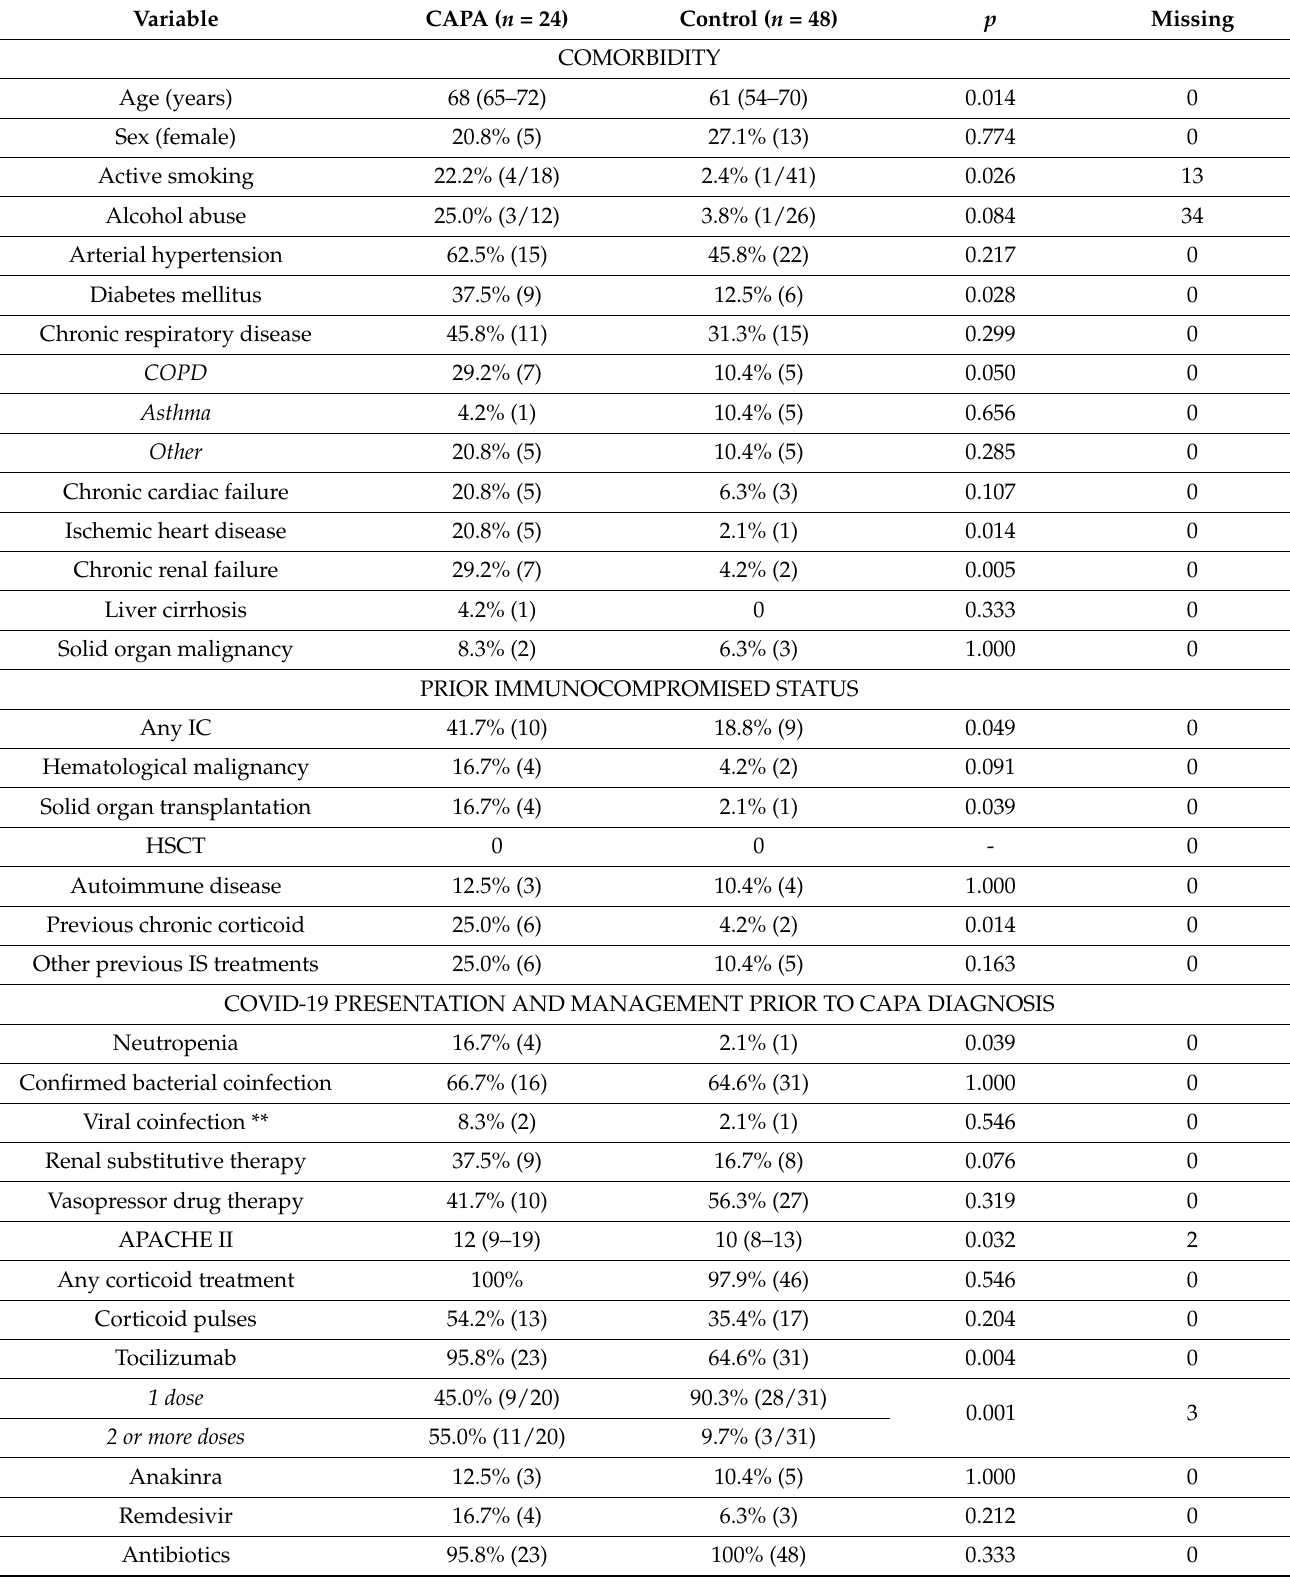
Table 1. Factors associated with CAPA versus